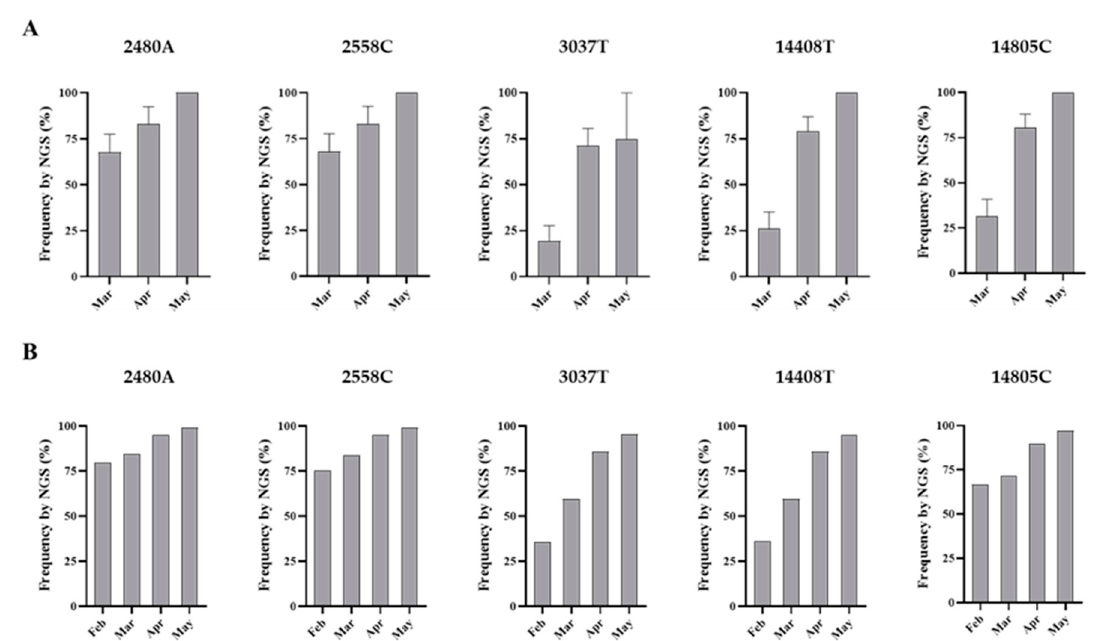
Figure 5. Nucleotide sequence variation at five selected genomic positions in SARS-CoV-2 RNA from wastewater concentrates. Comparison of mean sequence frequency values of nucleotides 2480A, 2558C, 3037T, 14408T, and 14805C found in nPCR1 and nPCR2 products ( A ) are shown and compared with mean sequence frequency values in clinical samples from England for the corresponding months ( B ). Error bars indicate standard error of the mean. Whole-genome SARS-CoV-2 sequences used in this analysis were downloaded from the GISAID database